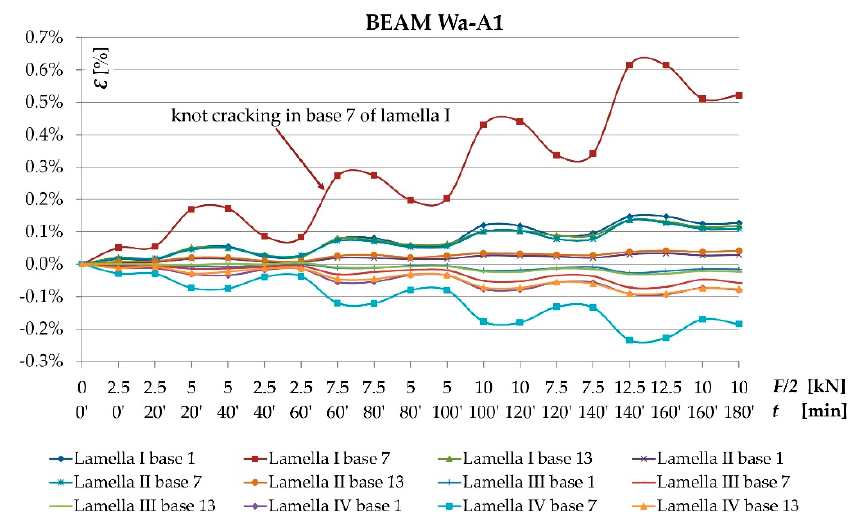
Figure 6. Chart of Ɛ [%] and F/2 [kN] - including time during loading dependency for the Wa-A1 reinforced beam.